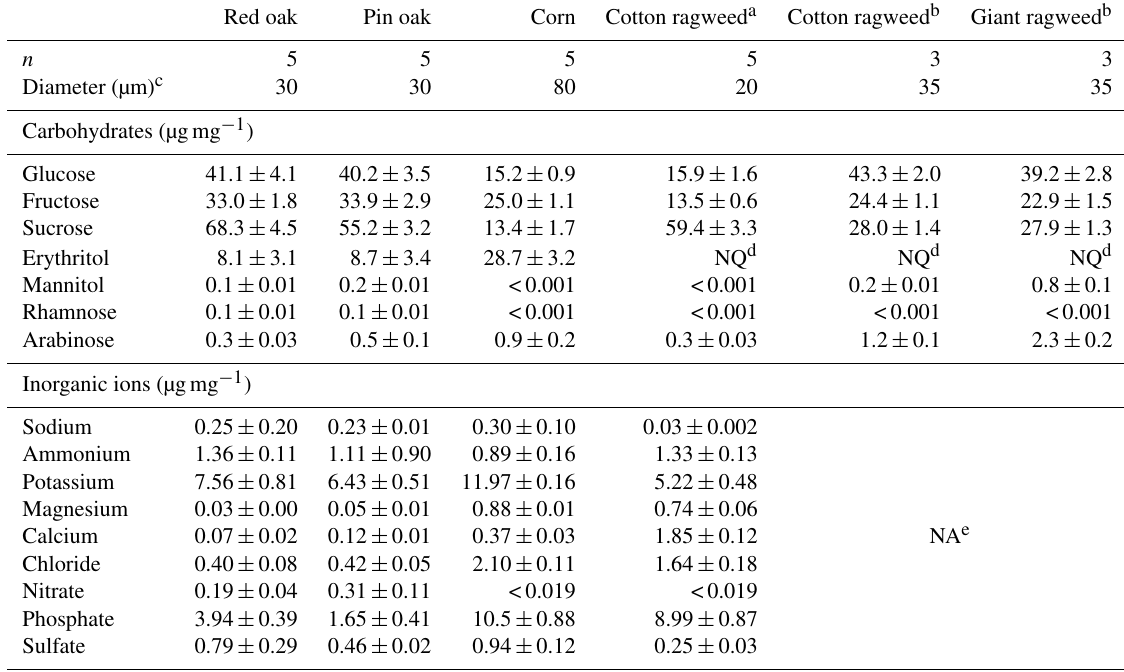
Table 1. Pollen diameter and mass fractions of carbohydrates and ions with standard errors. The carbohydrates arabitol, xylitol, trehalose, fucose, mannose, xylose, and ribose were below detection